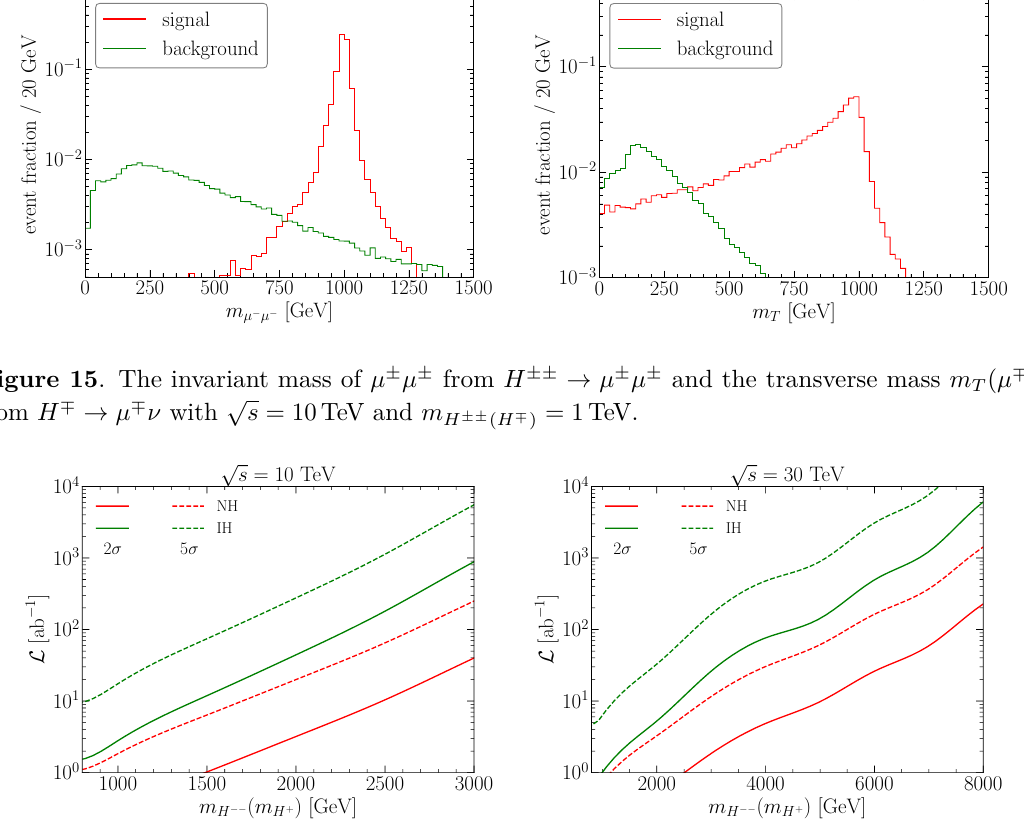
√ s = 10 TeV (left) and 30 TeV (right)